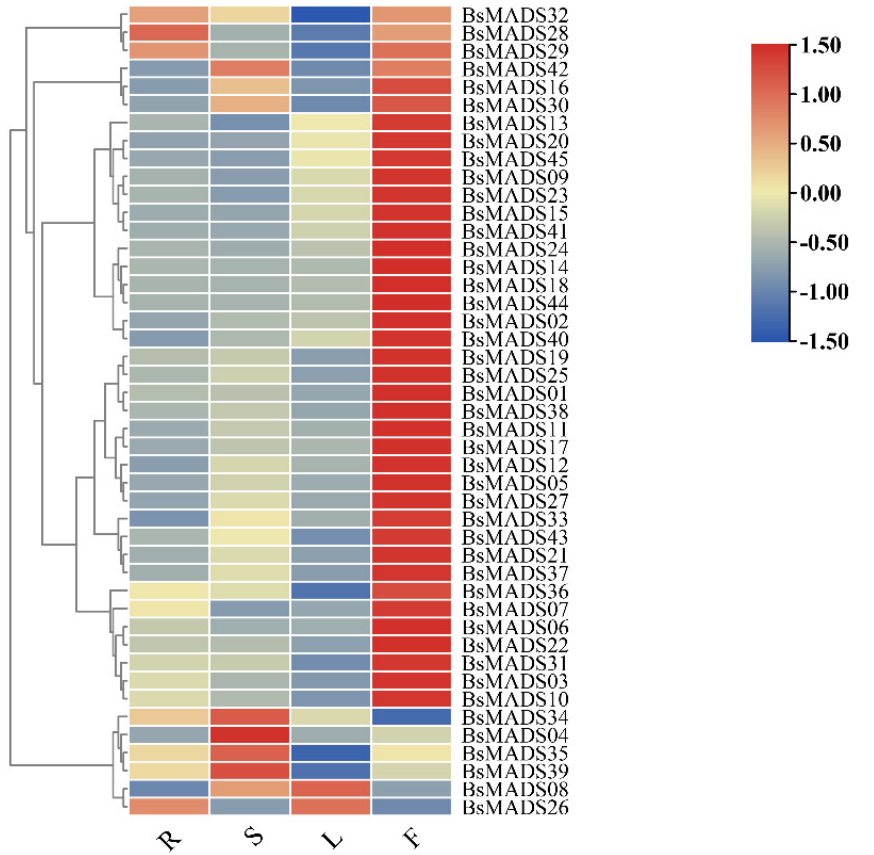
Figure 7. Heatmap showing the expression profile of BsMADSs in four different tissues (root, stem, leaf, and flower)—R (root), S (stem), L (leaf), and F (flower), respectively.